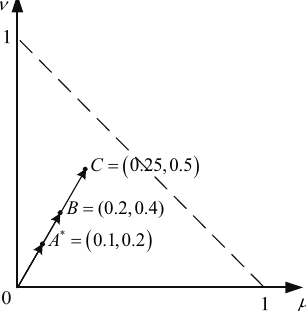
Fig. 1. A counter example using Ye’s cosine similarity measures based on